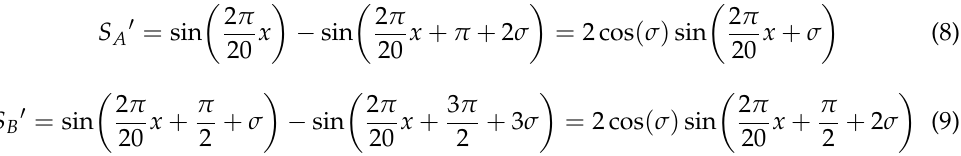
24 grating patterns correspond to the 24 pixels of the single ‐ filed scanning photoelectric device. The number of each grating pattern is shown in white at the bottom of Figure 4, and the size of each grating pattern is 0.26 mm (width) × 1.6875 mm (height). The grating period of d is 20 μ m. The yellow numbers in each grating pattern indicate the starting position, and the first, second, third, and fourth grating patterns begin with 0, 13 / 4 d d  , 26 3 / 4 d d  , and 39 / 2 d d  , respectively, and so forth. The four grating patterns form a group. The distance between the starting positions of two adjacent groups is 52 d . The four grating patterns in other groups are arranged in a similar way.